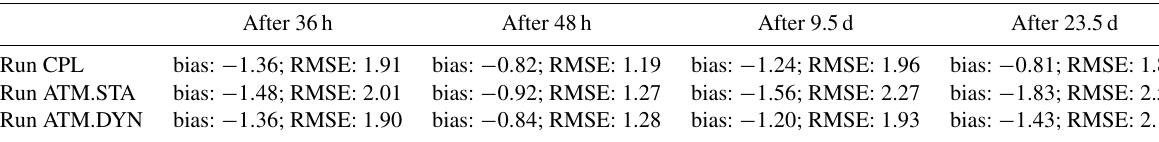
Table 3. The biases and RMSEs of T 2 simulated in all simulations in comparison with ERA5 data.